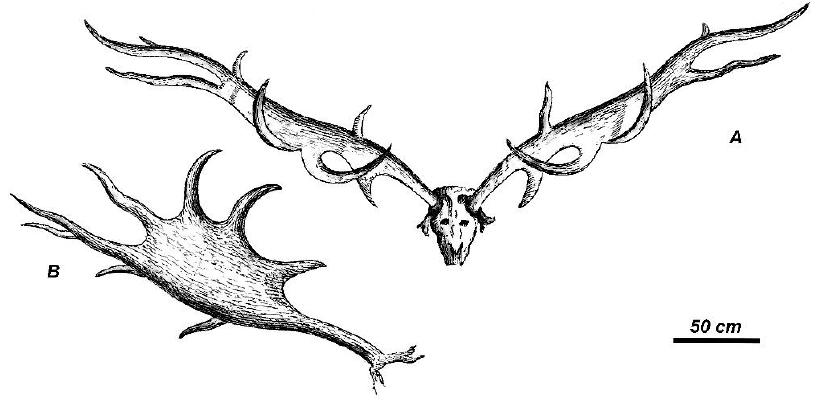
Figure 1. Original figure of the holotype of Megaloceros giganteus (Blumenbach, 1799) published in “Louthiana” by Wright [52]: ( A ), frontal view; ( B ), lateral view of right